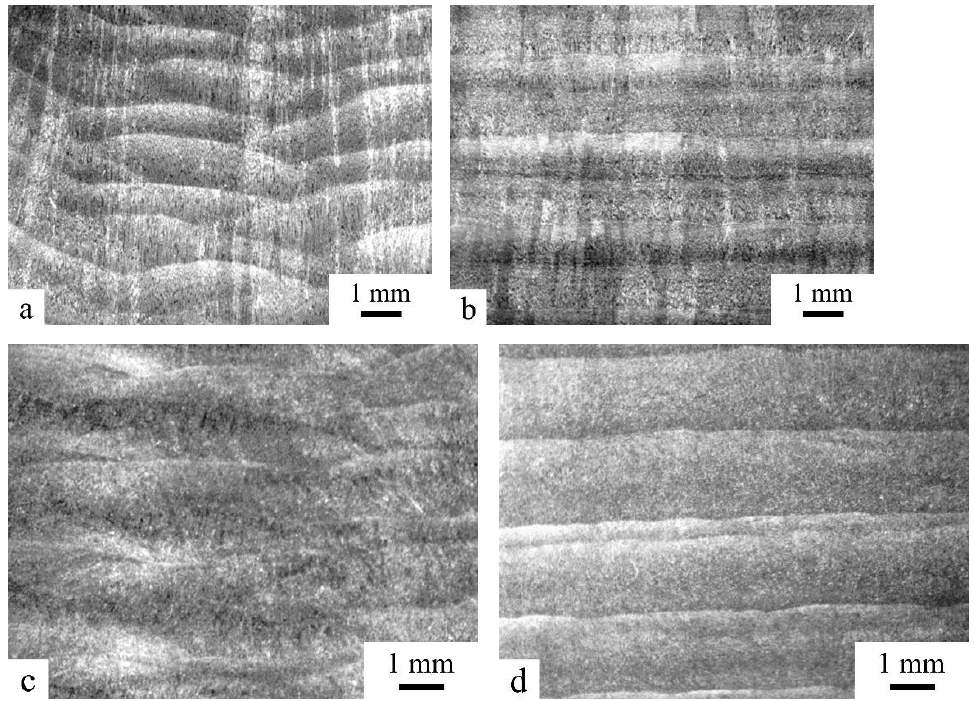
Figure 5. Macrostructure of the deposited metal: ( a , b )—deposition welding without layer-by-layer peeing, ( c , d )—deposition welding with layer-by-layer peening; ( a , c )—transverse section, ( b , d )— longitudinal section.